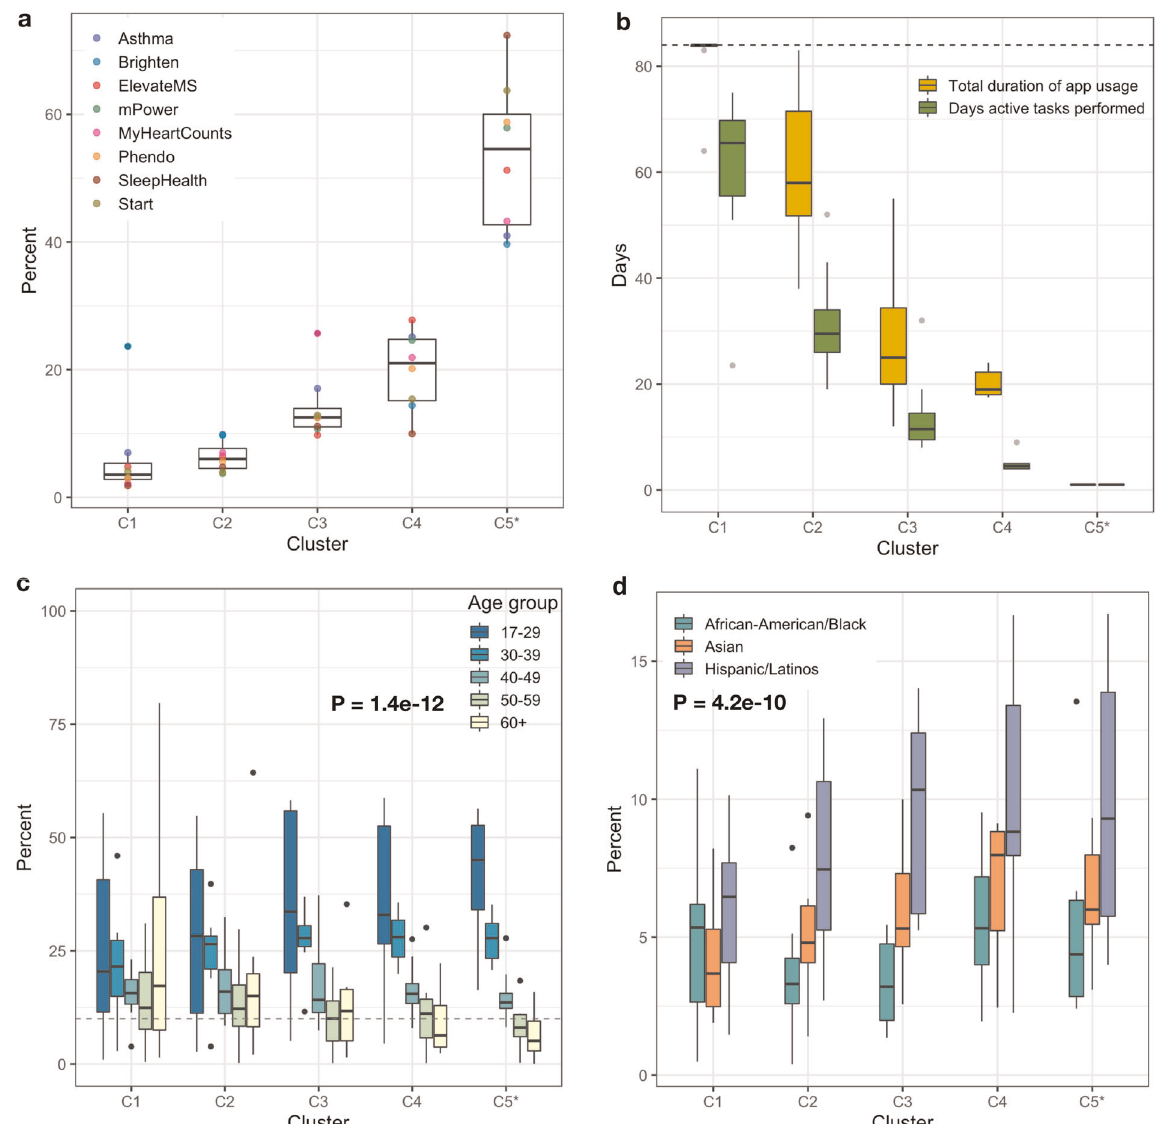
Fig. 4 Comparison of characteristics across participant engagement clusters. a Proportion of participants in each cluster across the study apps, b Participants total app usage duration(between 1 – 84 days) and the number of days participants completed tasks in the study apps, c Signi fi cant differences [F(4,163) = 18.5, P = 1.4e-12] in the age groups of participants across fi ve clusters and d Signi fi cant differences [F(2,81) = 28.5, P = 4.1e-10] in proportion of minority population present in the fi ve clusters. C5* cluster contains the participants that used the apps for less than a week and were removed from the clustering; however, they were added back for accurate proportional comparison of participants in each cluster. The centerline of the boxplots shows the median value across the studies for each cluster and upper and lower whisker corresponds to the outlier point that is at least 1.5 times the interquartile